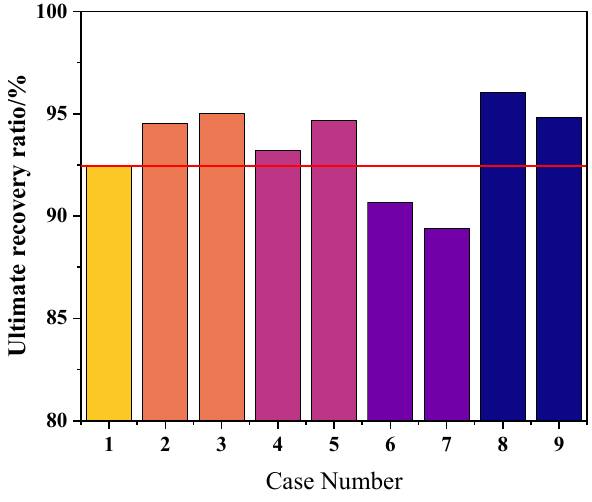
Figure 5. The ultimate recovery ratio of different cases.